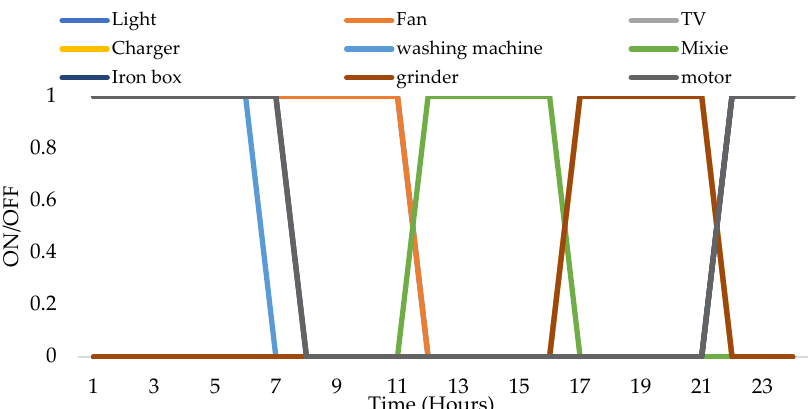
Figure 20. Individual power of home appliances.